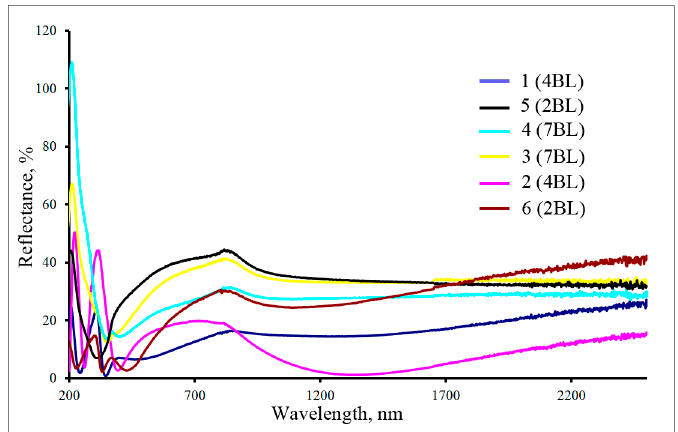
Figure 7. Reflection spectra of multilayer Al 2 O 3 /Ag nanocomposites with various architectures (see the legend and Al 2 O 3 part in Table 1).